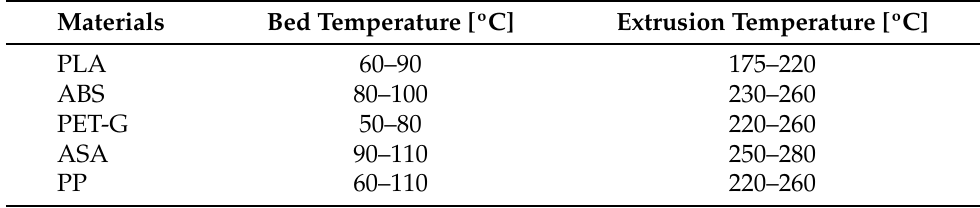
Table 2. Temperatures for the processing of the common FDM